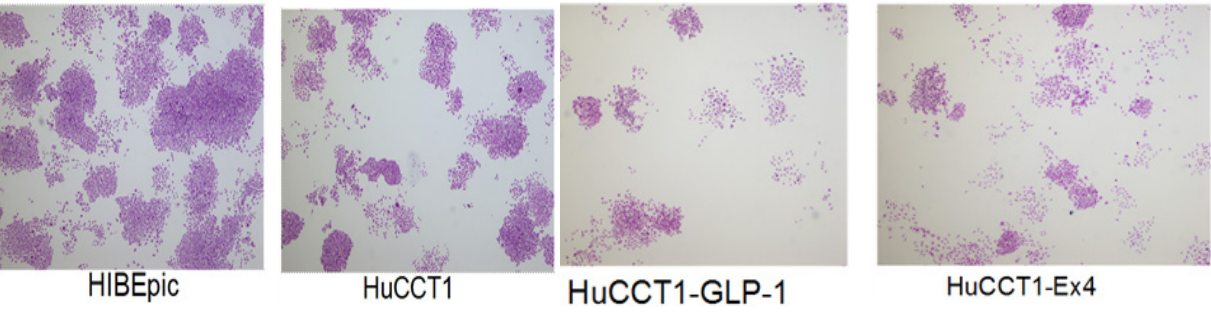
Figure 2. Colony formation experiment.